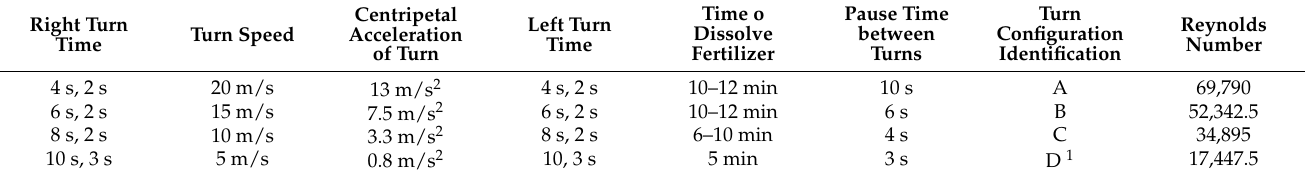
Table 2. Times obtained for dissolving 100 kg of granular ammonium sulfate in 100 L of